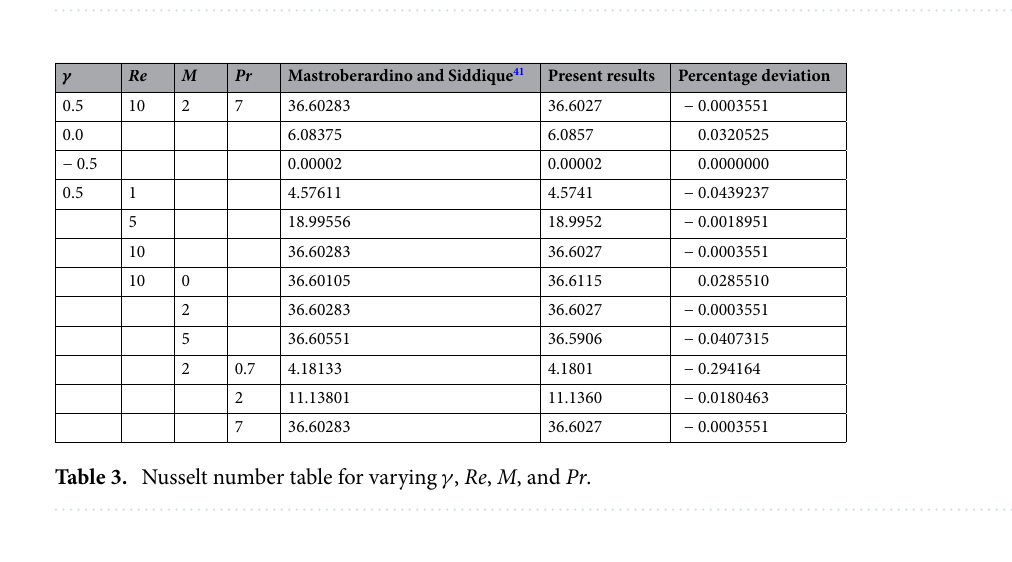
Table 2. The skin friction coefficient by varying M and Re .